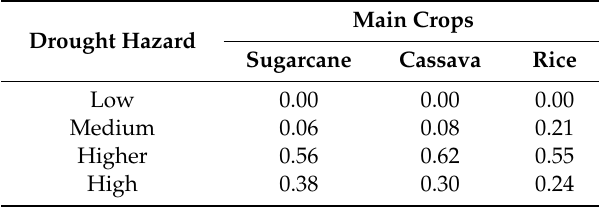
Table 5. Distribution of major crops for the di ff erent drought hazard grades in the LMR. Main Crops Drought Hazard Sugarcane